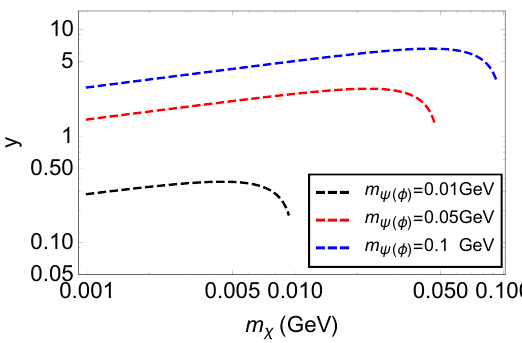
Figure 3. The cosmological bound on the DM-neutrino scattering cross-section as a function of the DM mass for various value of messenger masses. The dip at the end of each line corresponds to the increase in DM-neutrino scattering as m (cid:31) m (cid:30) . !